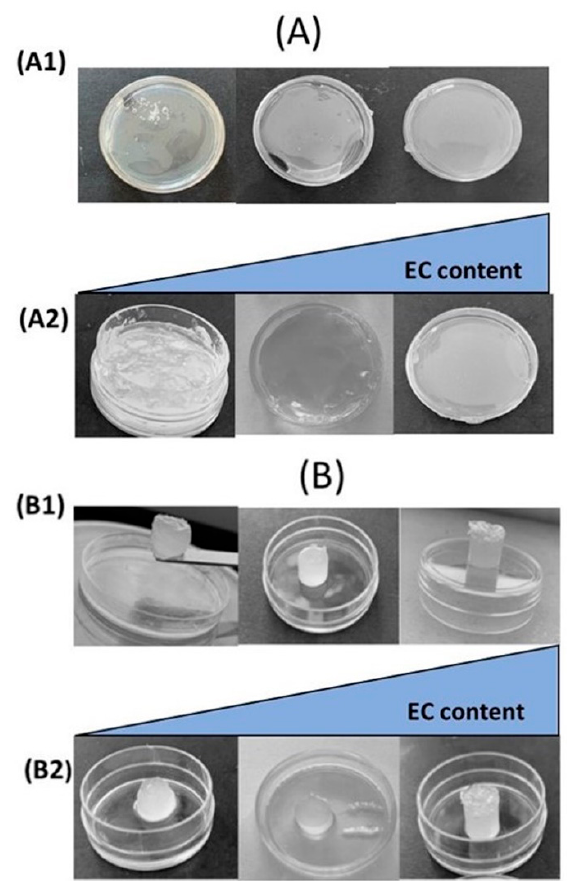
Figure 1. Macroscopic visual appearance of the EC/VCO-based oleogels prepared at different EC/VCO content ( A ) before molding—RT ( A1 ) and 37 °C ( A2 ); and ( B ) after molding—RT ( B1 ) and 37 °C ( B2 ).